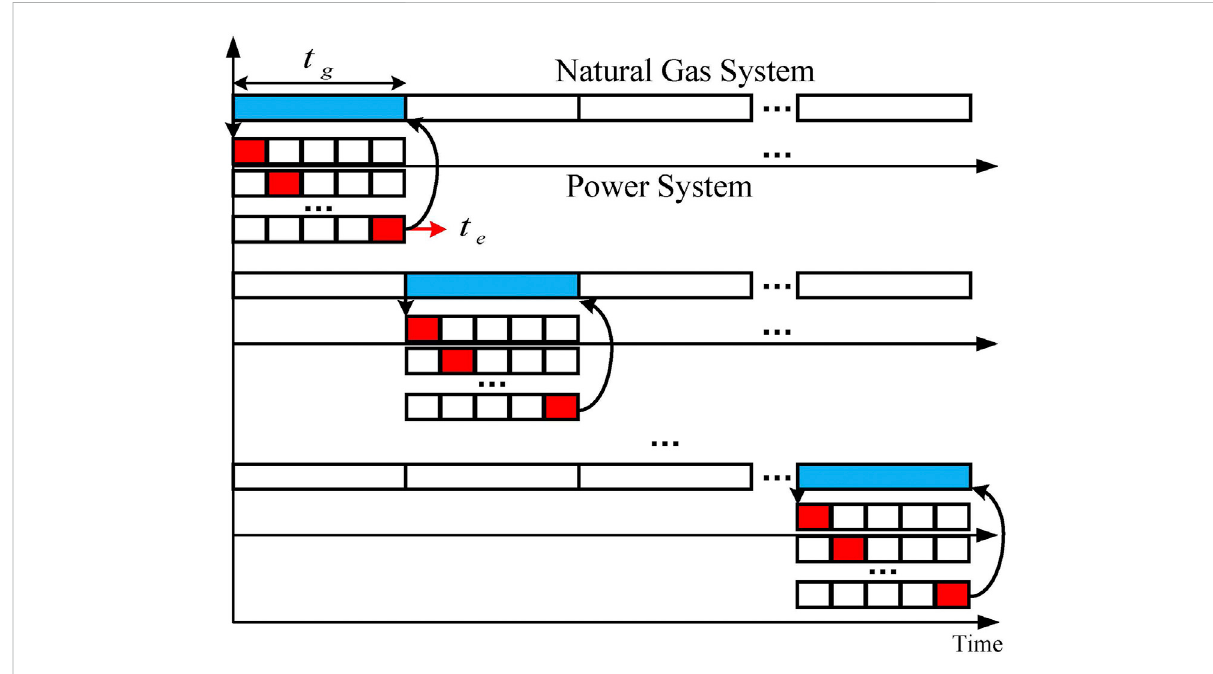
FIGURE 6 Multi-time scale scheduling optimization framework of the EGIES.